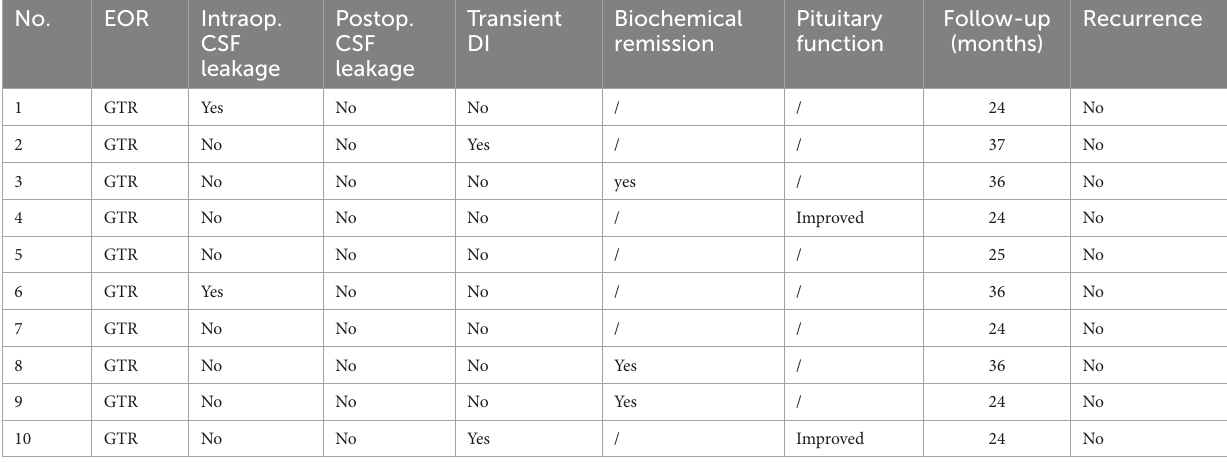
TABLE 2 Postoperative characteristics of 10 patients.